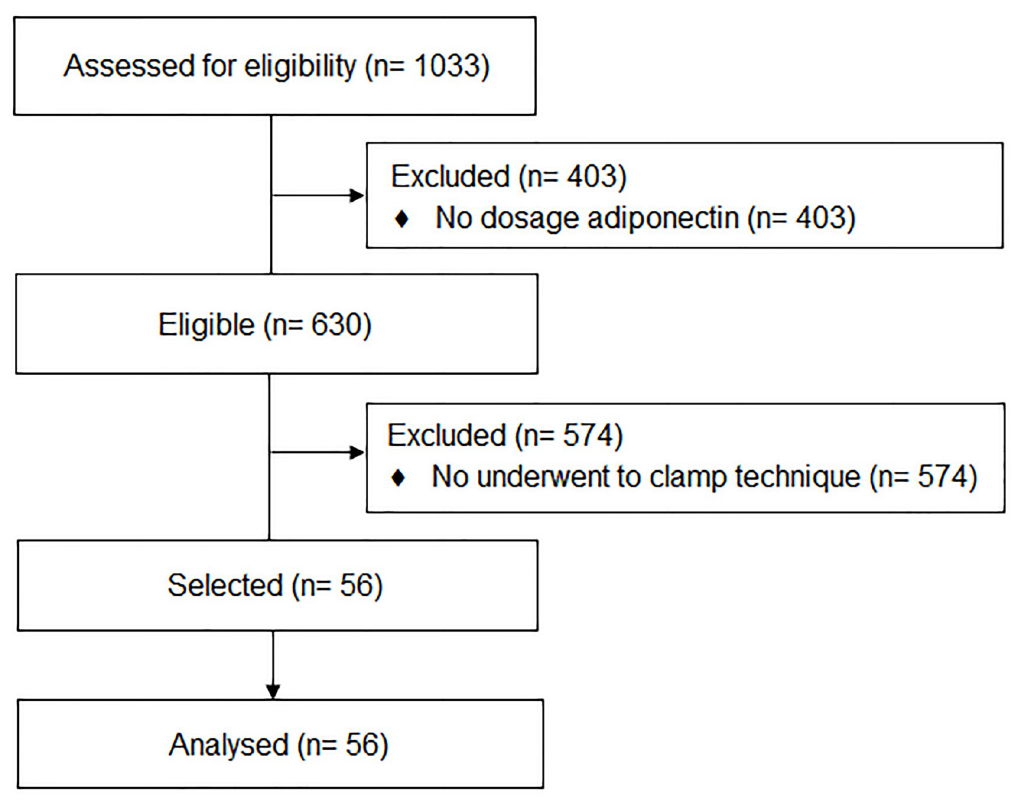
Fig 1. Flow diagram describing the selection of the study